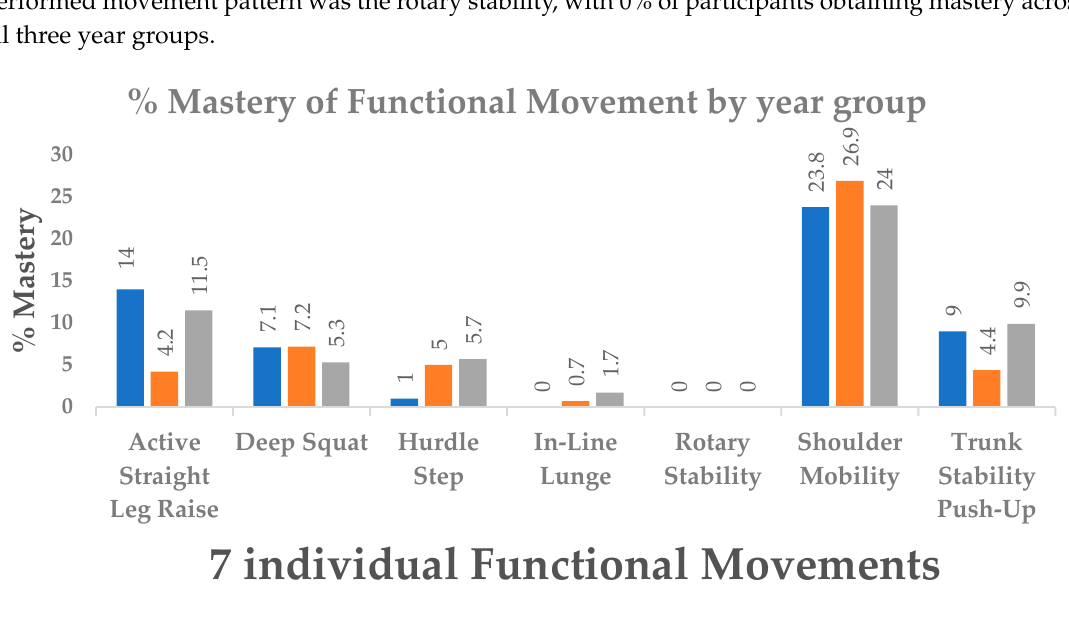
Table 2. Perceived motor competence (PMC) of the 10 FMS and 7 functional movements by year group.